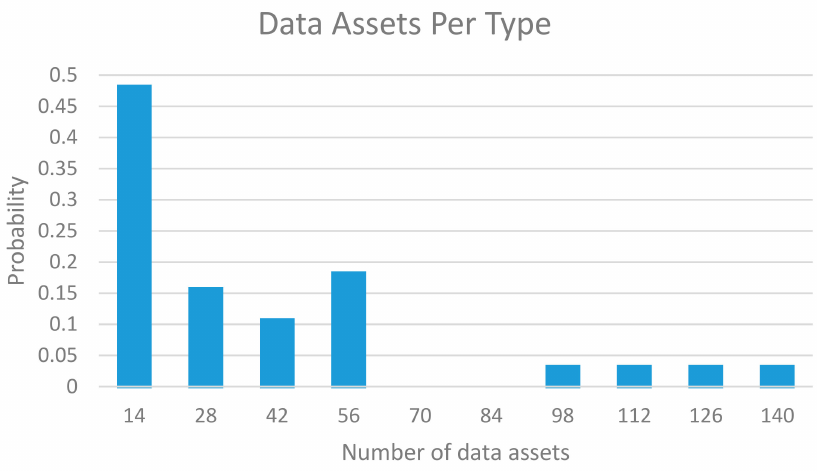
Figure 7. Probability distribution of types of data assets created by